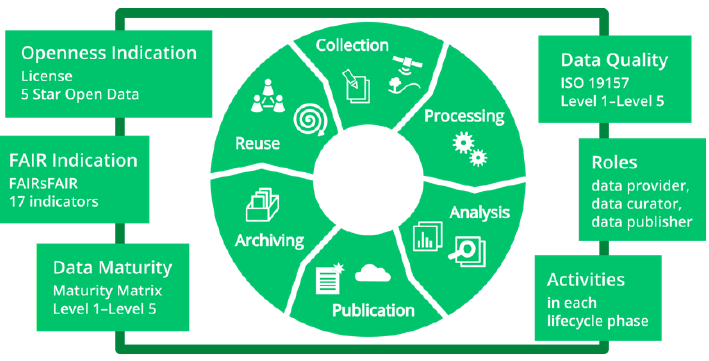
Figure 1. Data life cycle and aspects of developed quality assurance workflow